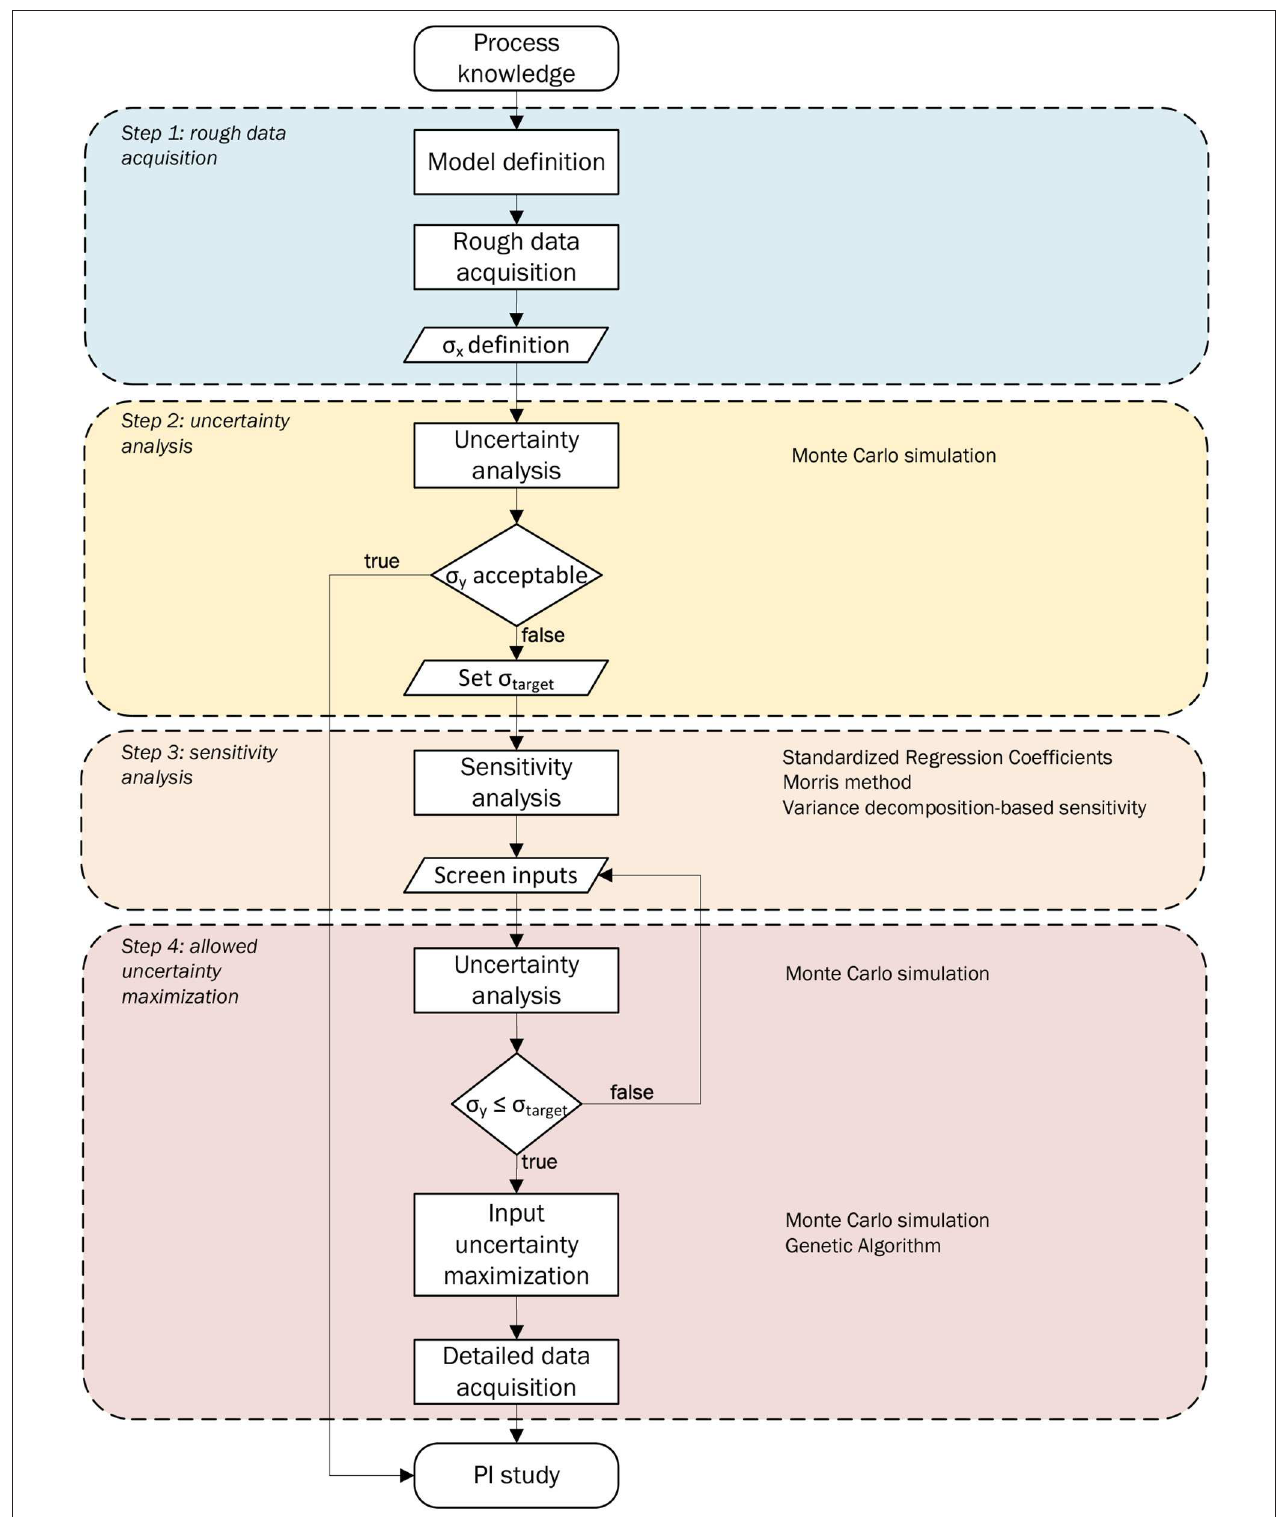
FIGURE 2 | Data acquisition simplification